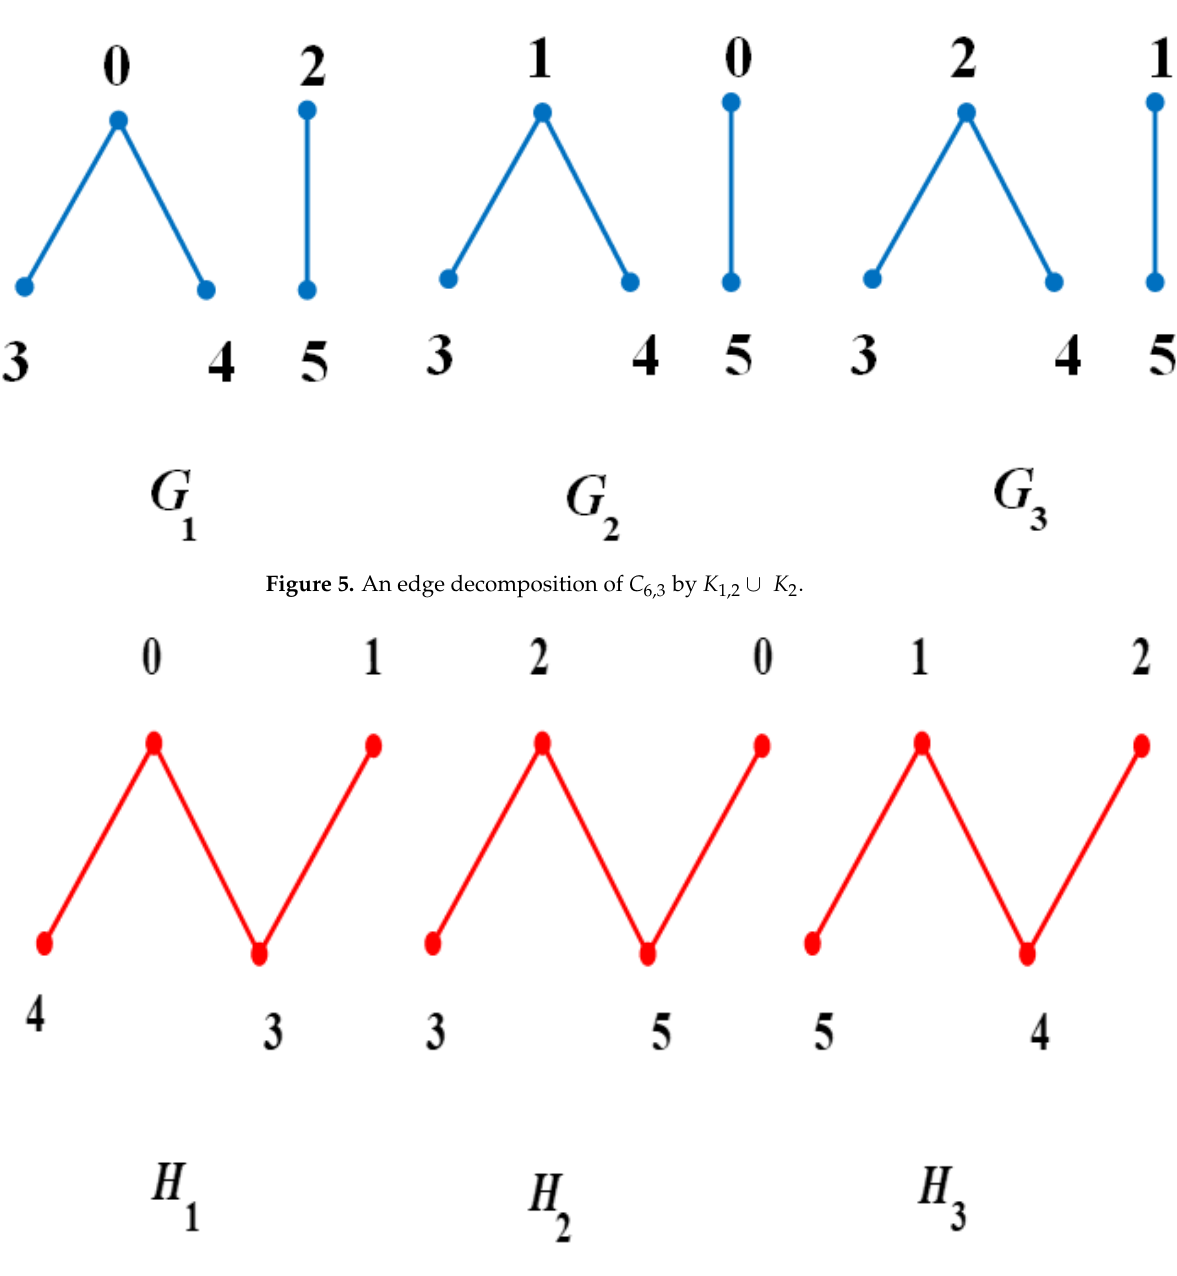
Figure 6. Edge decomposition of C 6,3 by P 4